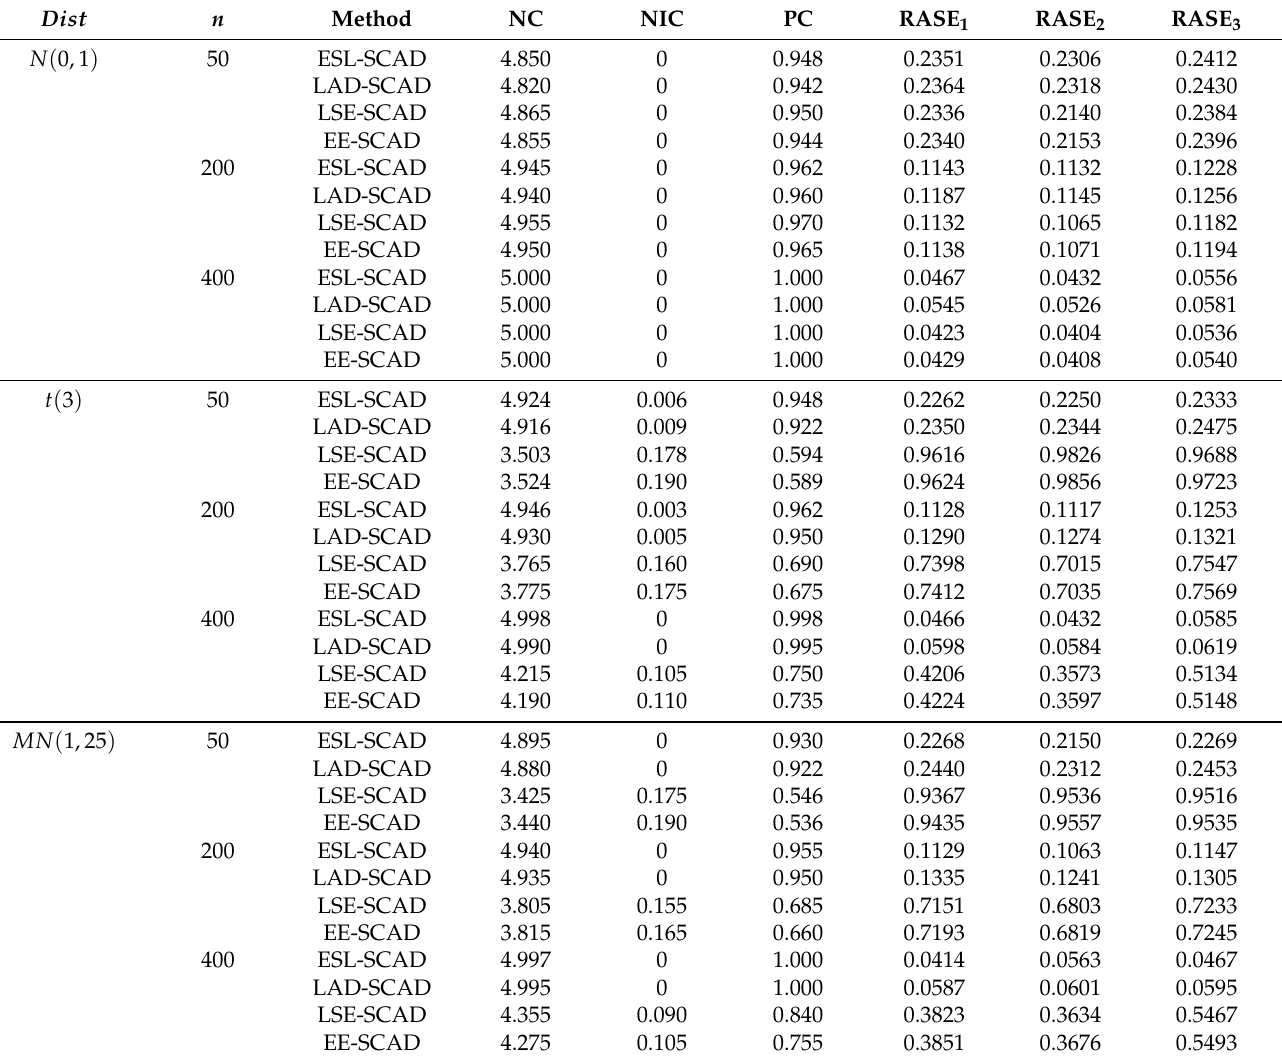
Table 3. Variable selection results and RASE of ˆ g k ( · ) , k = 1,2,3 in Example 2.